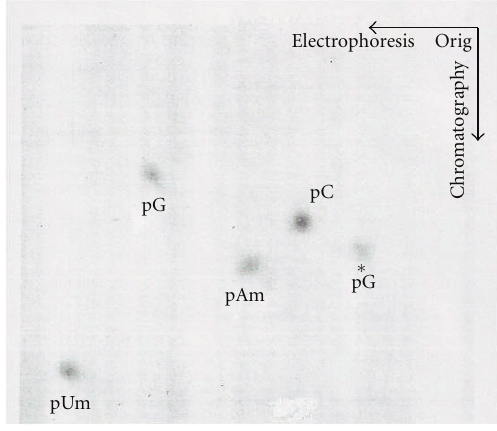
Figure 27: Autoradiograph of nucleotides from [ 32 P]-labeled U2 RNA 5 (cid:2) fragment [12]. The [ 32 P]-labeled U2 RNA 5 (cid:2) fragment (T1 RNase digestion) was treated first with alkaline phosphatase and then with snake venom phosphodiesterase. This mixture of mononucleotide products was separated by electrophoresis followed by chromatography. Approximately equal amounts of pm 32,2,7 G, pAm, pUm, pC, and pG were observed (Table 11).